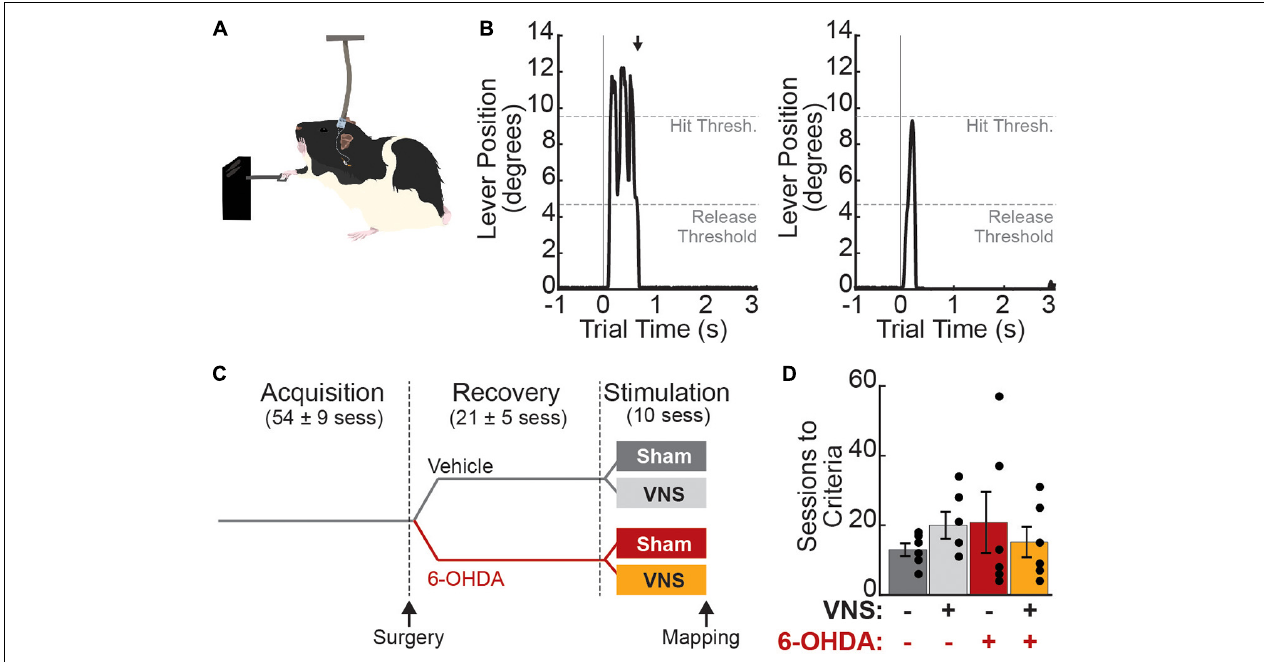
FIGURE 1 | Experimental design. (A) Rats were trained to perform a skilled reaching lever press task with their right forelimb. During treatment sessions, vagus nerve (or sham) stimulation was paired with correct lever press performance. (B) Correct trials (“hit trials,” left) were those in which the lever deflection exceeded 9.5 degrees below horizontal (Hit Threshold) followed by a return to less than 4.75 degrees (Release Threshold) within 2 s. Black arrow denotes the time of reward delivery, which was coincident with detection of lever release. Miss trials (right) were those in which the hit threshold was not reached (shown) or in which the rat failed to release the lever within the 2 s trial window. (C) Rats were trained to criterial performance prior to VNS cuff implantation and 6-OHDA (or vehicle) infusions in left M1, i.e., contralateral to the trained limb. After behavioral recovery, rats received 10 stimulation sessions in which VNS or sham stimulation was paired with correct lever performance ( N = 6 rats per treatment group). Values in parentheses are mean ± SEM for the number of sessions in each training epoch for all 24 rats in the main study. (D) Rats in all treatment groups required a similar number of sessions to first reach criterial task